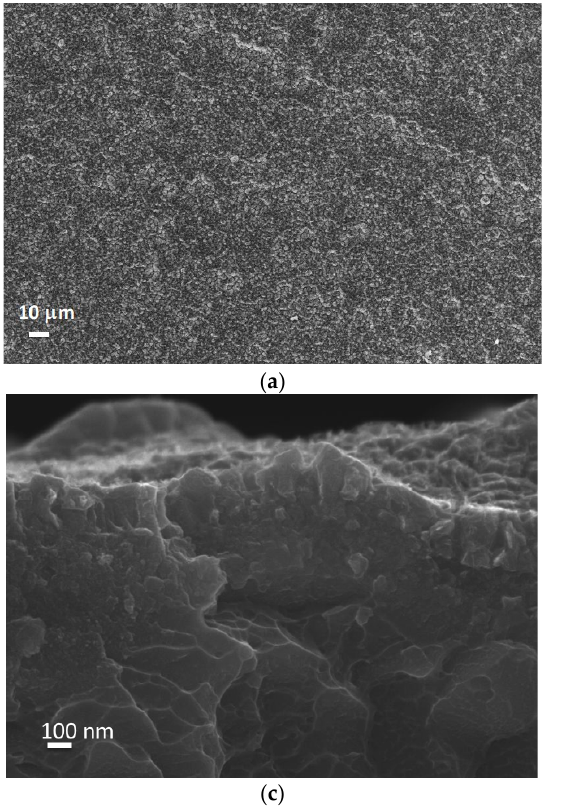
Figure 7. Surface ( a ) and cross-sectional ( b ) SEM micrographs of the ZrVTiPd6 membrane after permeability tests and a particular ( c ) of the surface Pd thin film.